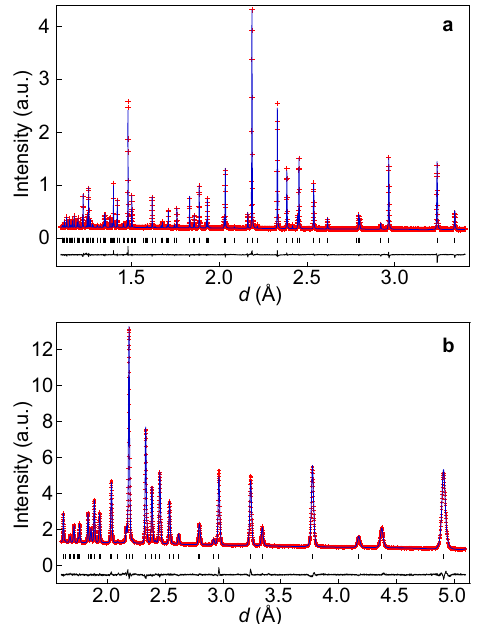
Fig. 3 Rietveld patterns of Ba 7 Nb 3.9 Mo 1.1 O 20.05 at 800 °C. Rietveld patterns of neutron-diffraction data taken with the ( a ) backscattering bank ( d = 1.1 − 3.4 Å) and ( b ) 90 o bank ( d = 1.6 − 5.1 Å) of the SuperHRPD diffractometer in vacuum at 800 °C. The observed and calculated intensities and difference plots are shown by red marks, blue and black solid lines, respectively. Black tick marks stand for calculated Bragg peak